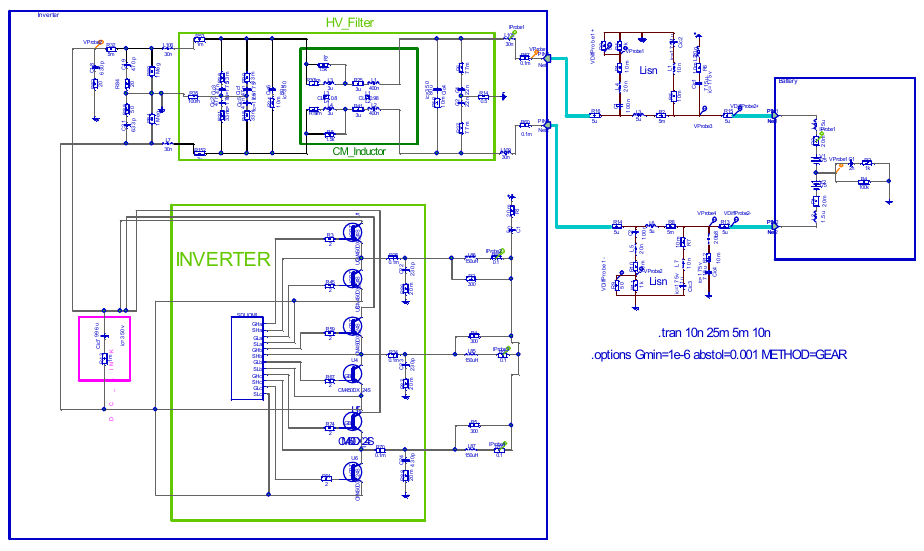
Figure 23. Simple inverter setup. The results of the calculation times are shown in Table 1. Table 1. Results of calculation time.